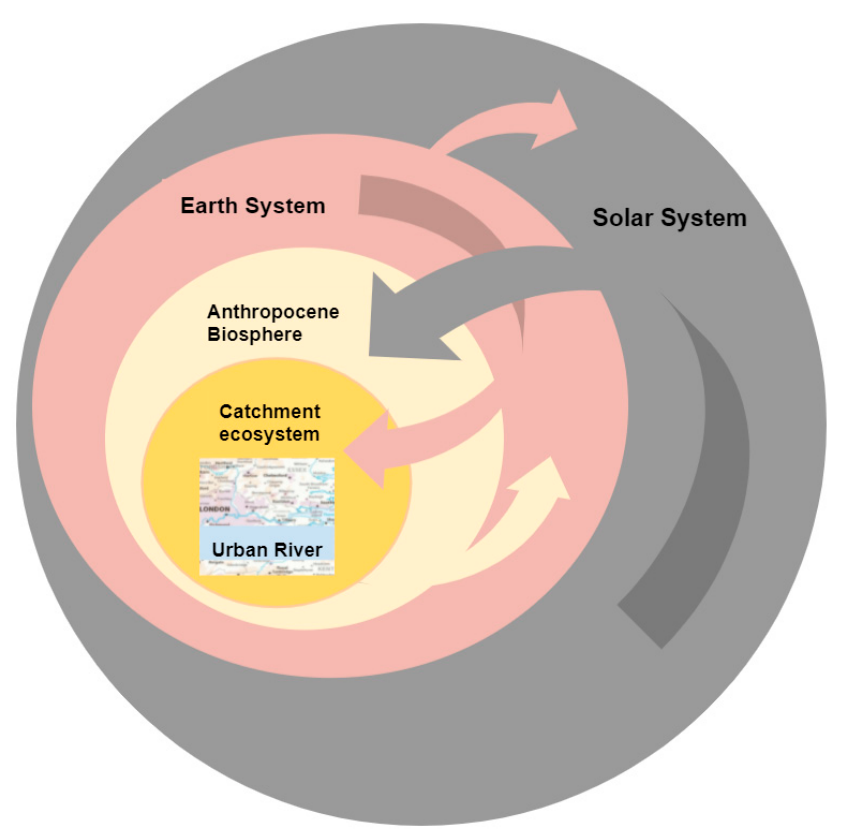
Figure 1. Interactions between nested, interconnected systems operating over different spatial and temporal scales. The solar system affects tides, causes mutations in DNA through cosmic radiation, mass extinctions and changes in geomorphology through meteor impacts, and solar energy powers much of life on earth. The Earth system returns heat to space in maintaining equilibrium and affects the biosphere in multiple ways, including climate change. Feedbacks from the biosphere influence the Earth system and return anthropogenic pollution.